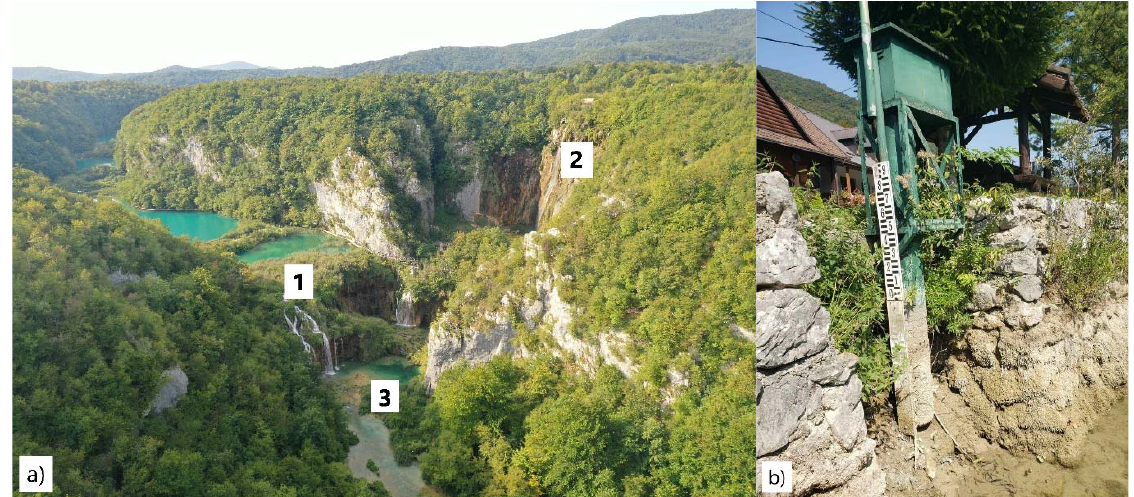
Figure 2. ( a ) The Korana River source: 1—inflows from the Plitvice Lakes; 2—Plitvica stream; 3—beginning of the Korana River (Sastavci) (photo: Plitvi č ka Jezera National Park staff). ( b ) Dried out part of the Korana River course at the Luketi ć i hydrological station (photo: DMHZ).